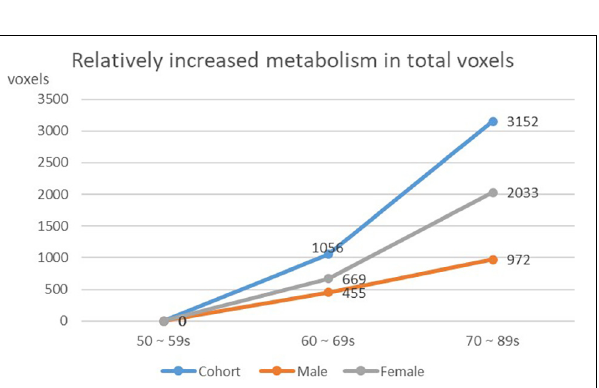
FIGURE 4 | Decreasing of whole brain voxels in cohort and different gender groups.